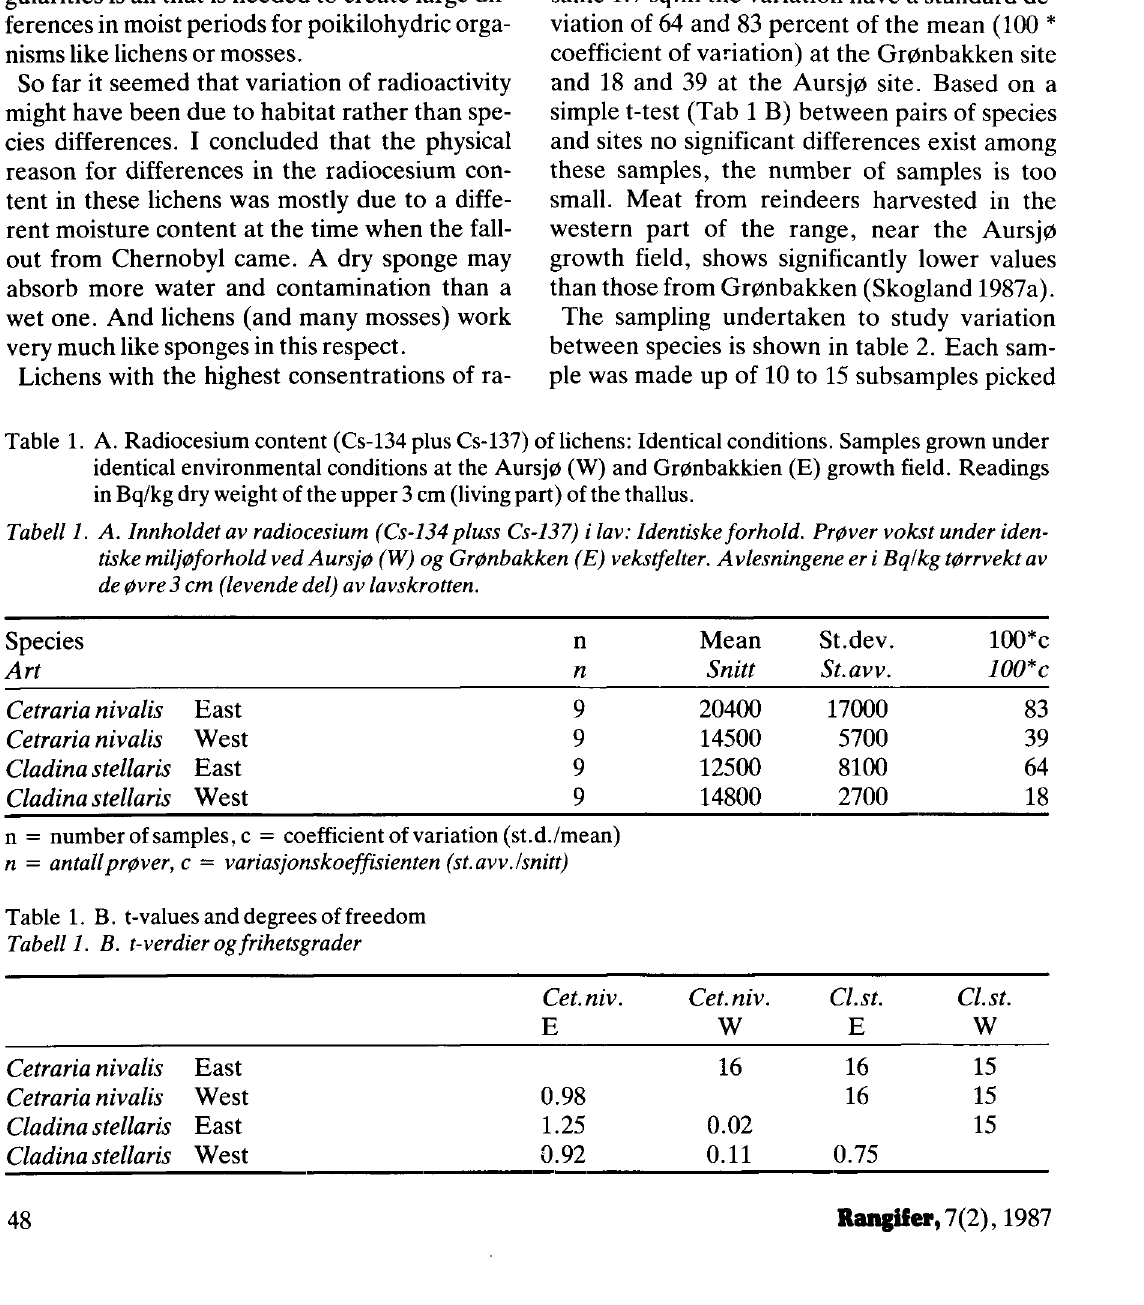
Table 1. A. Radiocesium content (Cs-134 plus Cs-137) of lichens: Identical conditions. Samples grown under identical environmental conditions at the Aursjø (W) and Grønbakkien (E) growth field. Readings in Bq/kg dry weight of the upper 3 cm (living part) of the thallus.